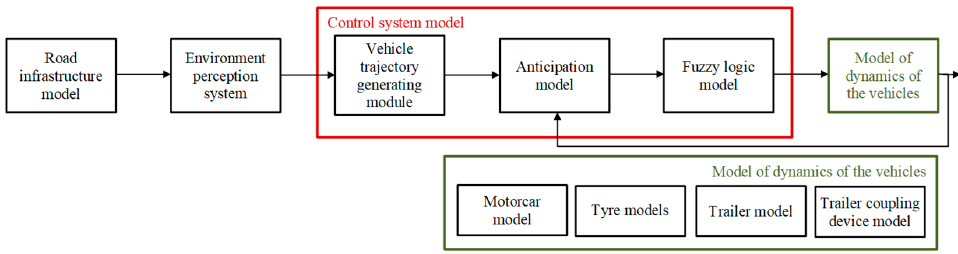
Figure 2. Structure of the control system.